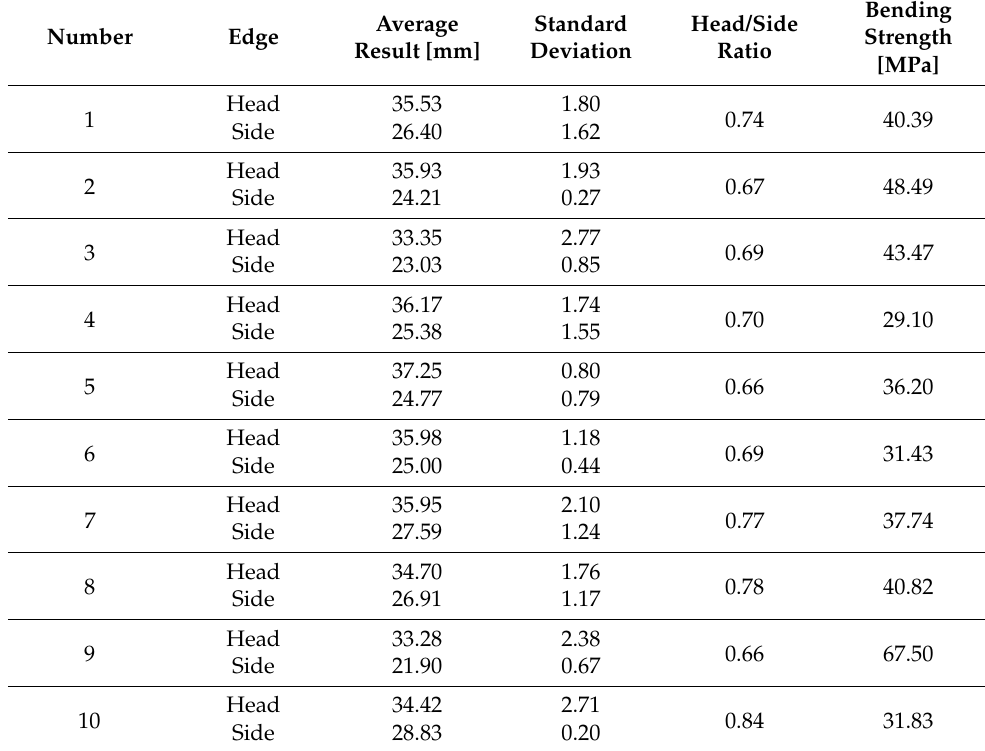
Table 3. Results of Schmidt hammer tests for pine wood elements and bending strength obtained in the destructive test in accordance with